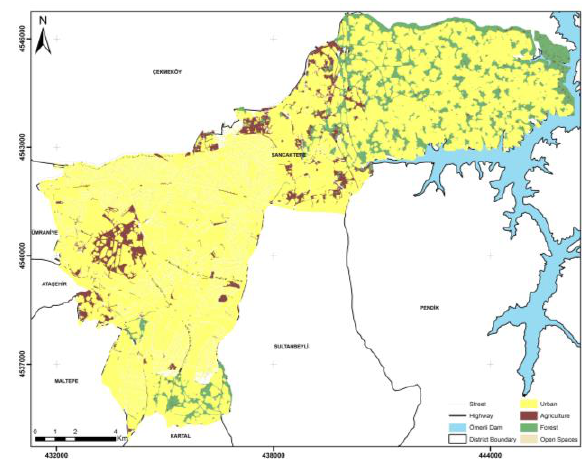
Figure 2. Land cover for